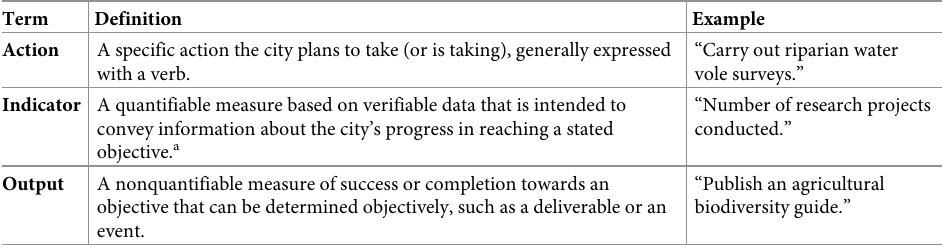
Table 2. Definitions of plan